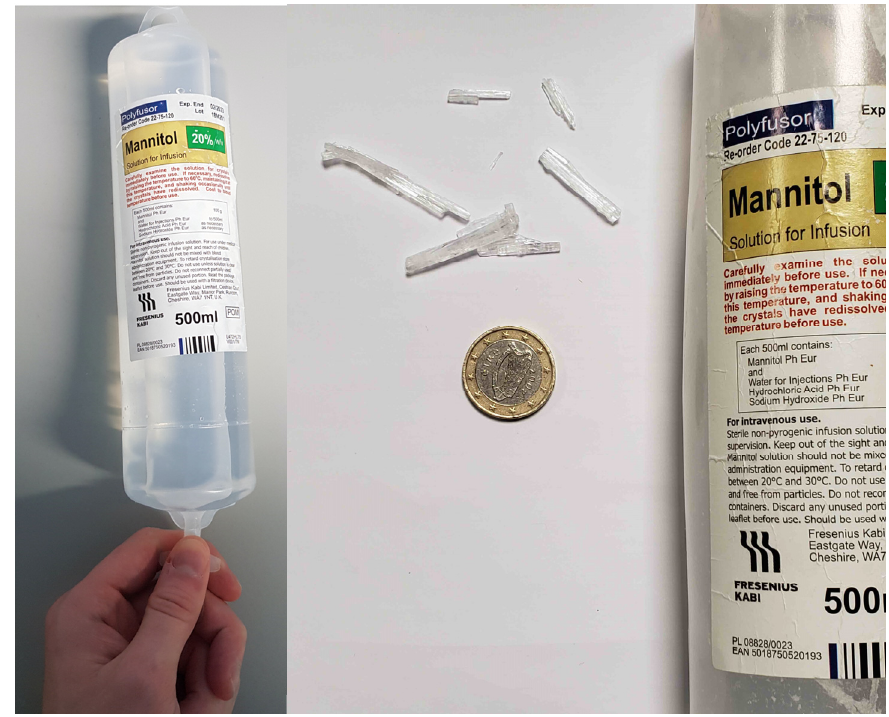
Figure 1. Photograph of mannitol infusion solution ( left ) and crystals were taken from solution after precipitation ( right ).